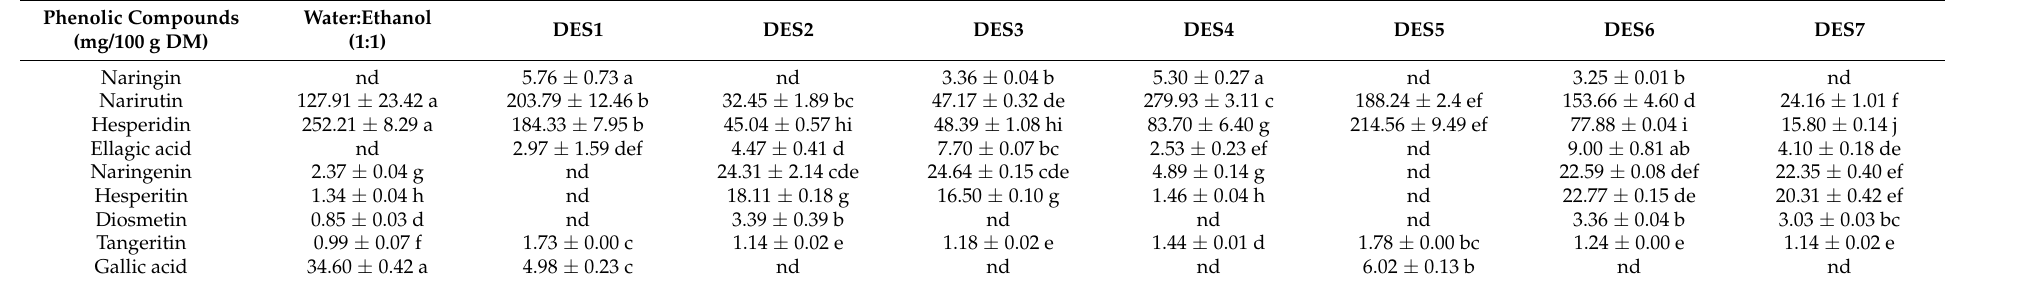
Table 7. Individual phenolic compounds obtained for group 2 extractions by One extraction step–E1S.